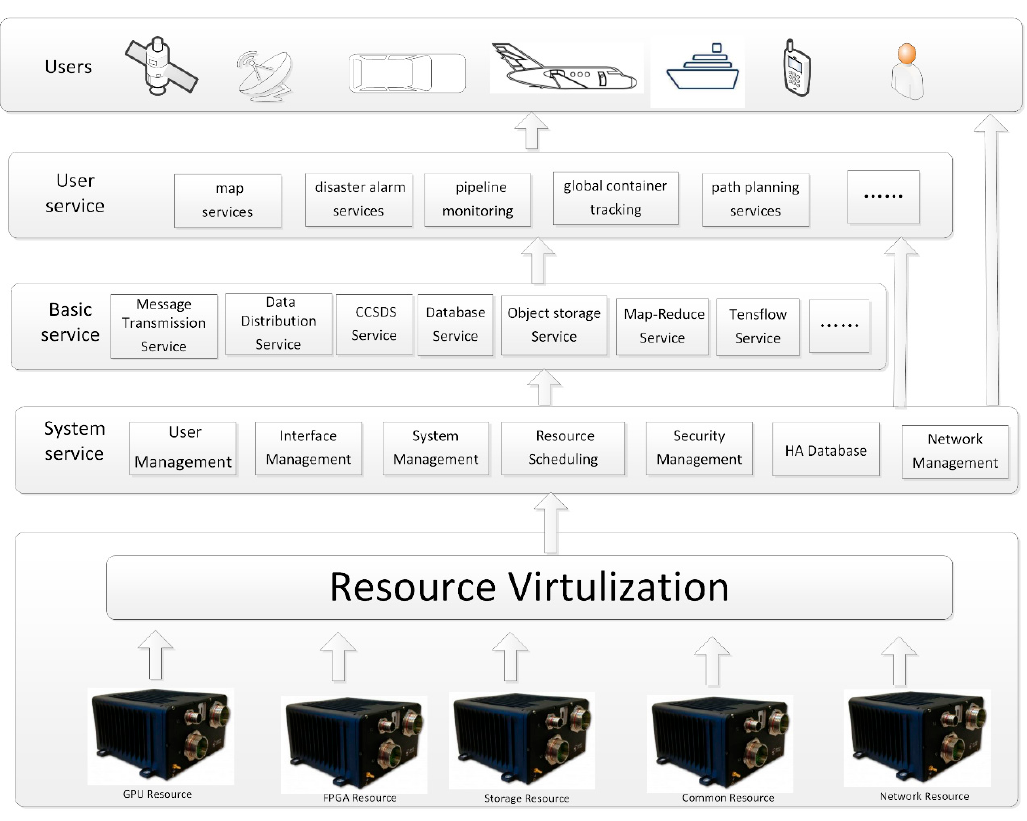
Figure 1. The framework of 5GsatEC.